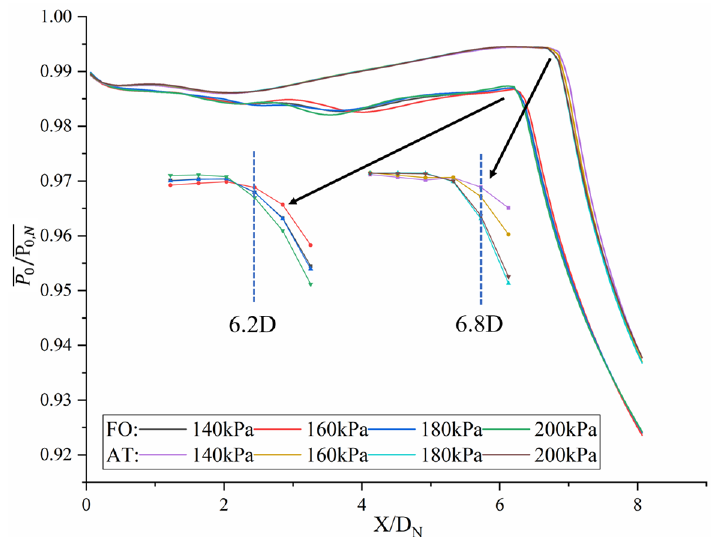
Figure 14. Centerline dimensionless total pressure distribution in various cases.